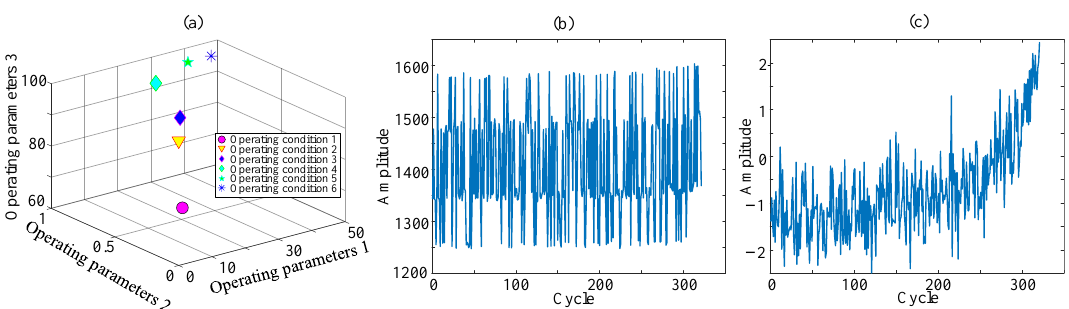
Figure 5. The information of the simulation dataset. ( a ) The partition of different operating condition. Three axes respectively denote three operating parameters, and each point in the figure denotes one specific operating condition decided by three different parameters. ( b ) The measured value of the sensor. ( c ) The standardization of measured value.